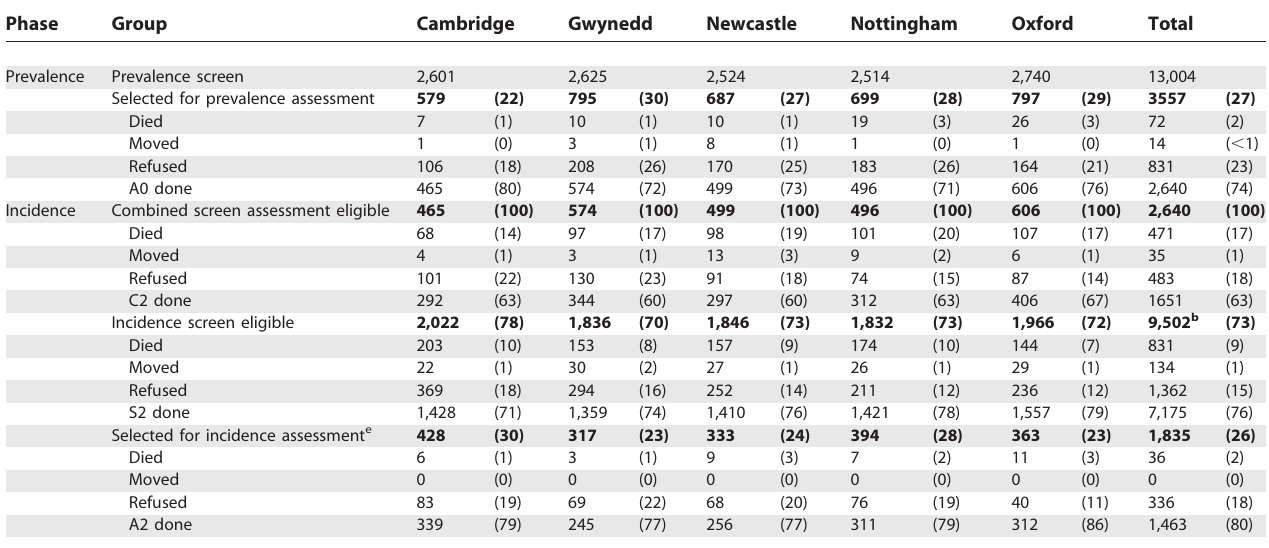
Table 1. Numbers Included in the First Two Waves of MRC CFAS, Version 6.2